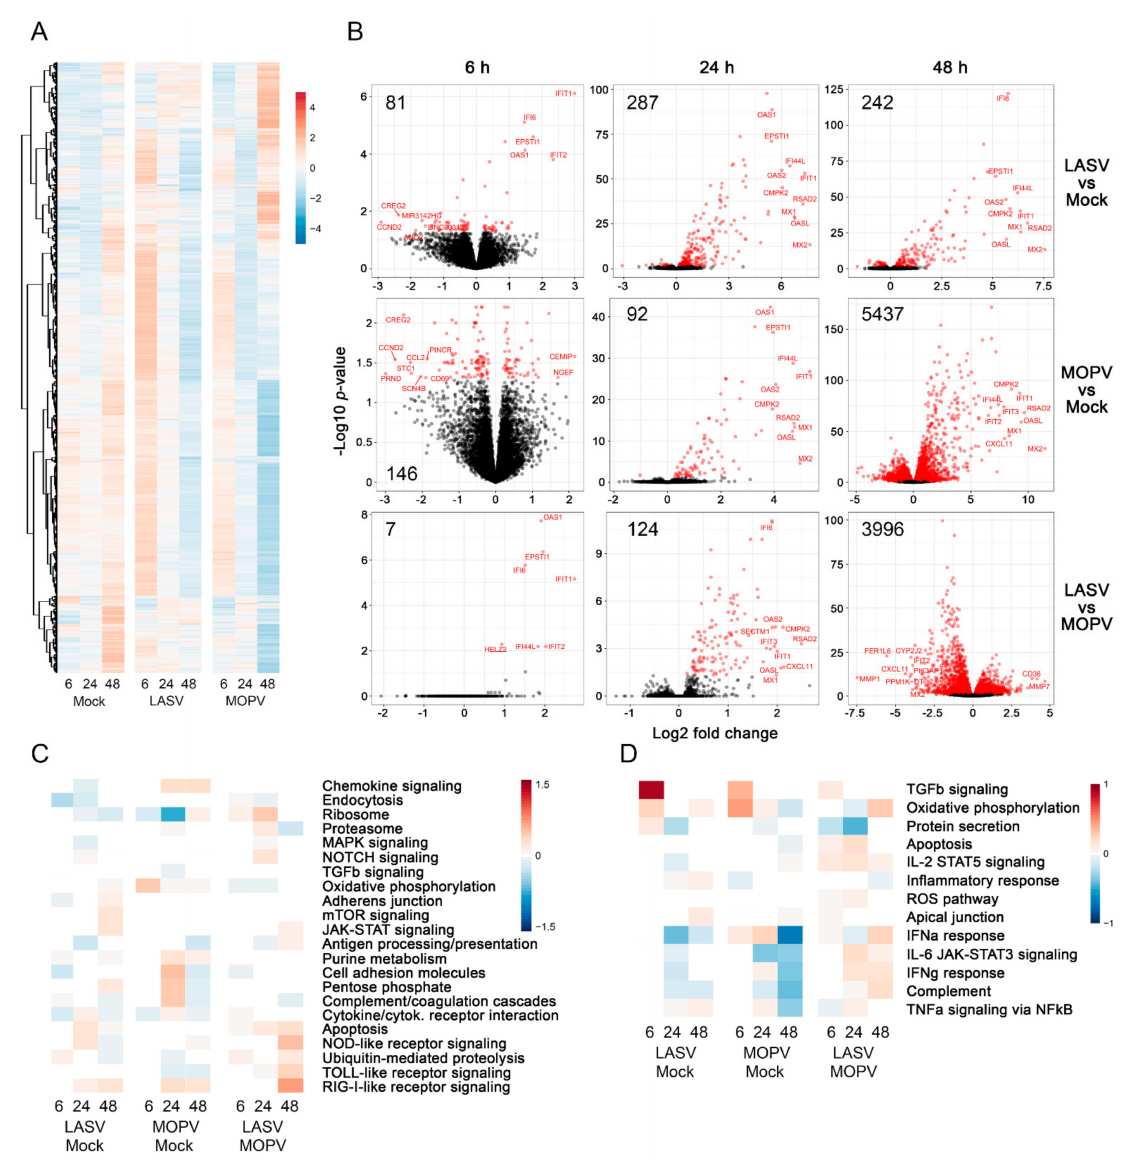
Figure 2. Transcriptomic profiles of infected HUVECs. ( A ) Heatmap of the total DE genes (abso- lute Log2 fold-changes) 6, 24, and 48 h after infection. Gene expression was standardized by VST transformation; hence, the results are centered and scaled to make the gene expression compara- ble. Each column represents the mean gene expression of the three donors of each group for a given timepoint. ( B ) Volcano plots representing the DE genes (red circles) (threshold of adjusted p -value < 0.05) between LASV and mock (upper row), MOPV and mock (middle row), and LASV and MOPV conditions (lower row) at 6 (left column), 24 (middle column), and 48 h (right columns) after infection. Each circle corresponds to the mean gene expression of the three donors. The x -axis reflects the Log2 fold-changes in expression for each given gene in the first condition with respect to the second condition. The y -axis accounts for the statistical significance of these results calculated as the–(minus) Log10 of the p -values. The number of DE genes for each comparison is shown in the upper left of graphs. Heatmaps of the CAMERA scores for the most significant pathways according to the analysis performed on KEGG ( C ) and Hallmark ( D ) gene sets from MSigDB. Comparisons between groups are shown on the x -axis and gene sets on the y -axis. The color of each cell (red and blue) corresponds to pathways that were significantly upregulated or downregulated, respectively. A gene set is considered to be upregulated or downregulated if its CAMERA score is positive or negative,